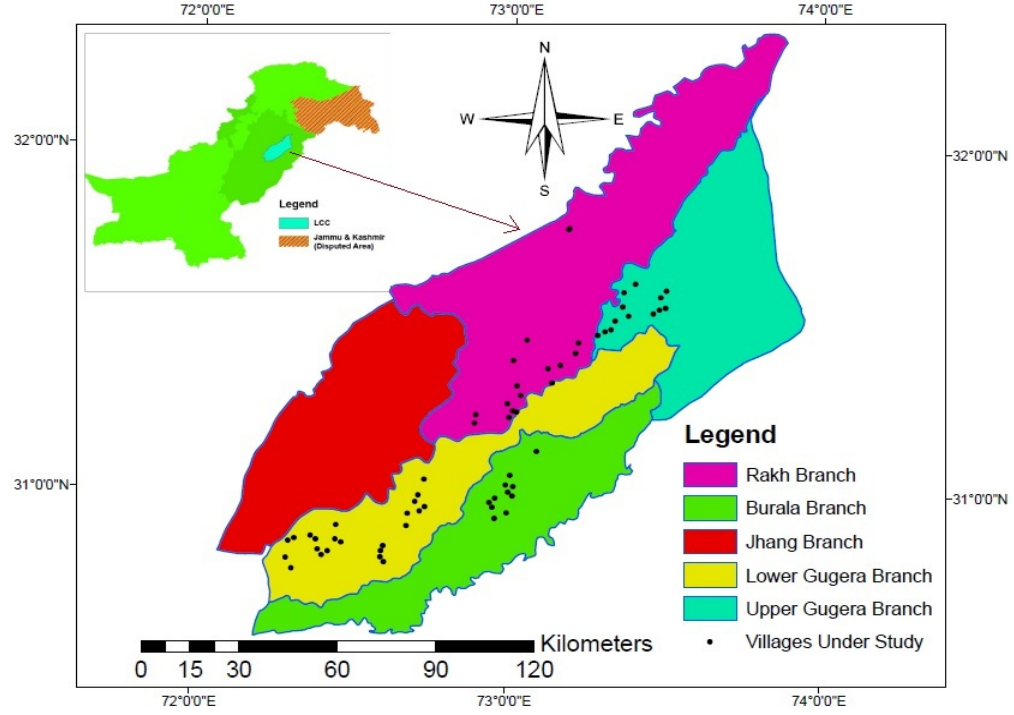
Figure 1. Location of study area.